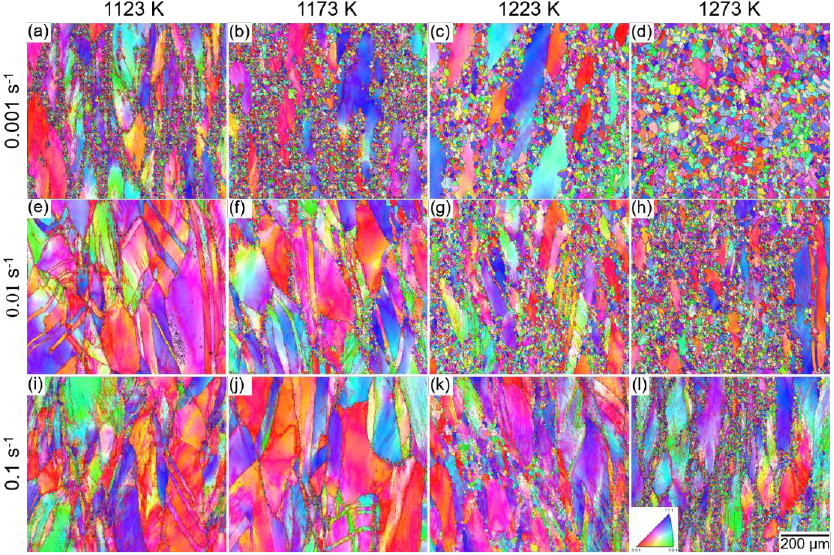
Figure 5. Electron backscatter diffraction (EBSD) inverse pole figure (IPF) maps of the Co 35 Cr 25 Mn 15 Ni 15 Fe 10 TRIP-HEA hot-compressed at ( a , e , i ) 1123 K, ( b , f , j ) 1173 K, ( c , g , k ) 1223 K, and ( d , h , l ) 1273 K with strain rates of ( a – d ) 0.001 s −1 , ( e – h ) 0.01 s −1 , and ( i – l ) 0.1 s −1 .